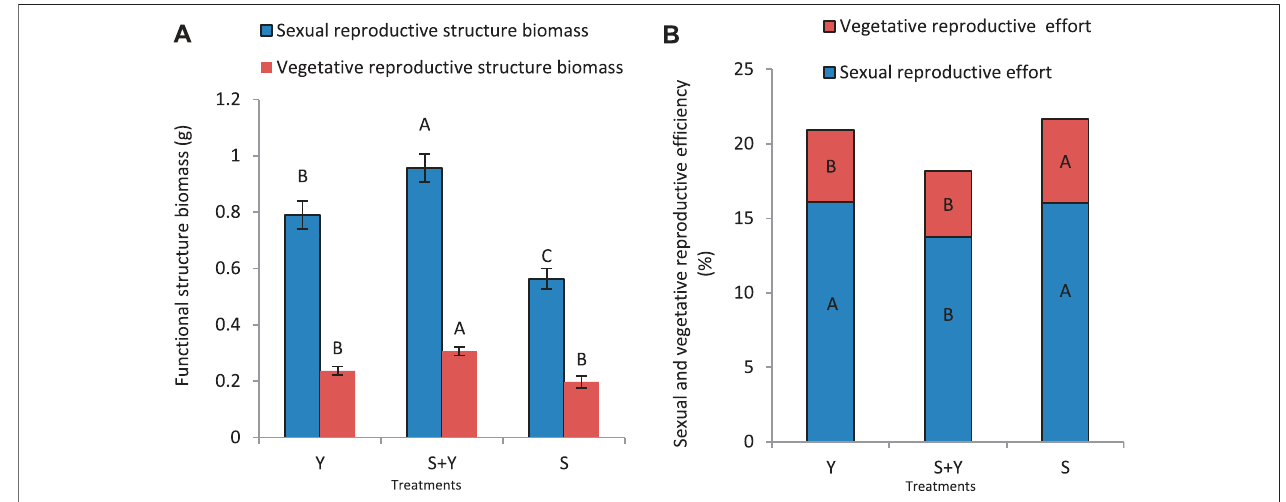
FIGURE 8 | Trade-off between grazing methods on sexual and vegetative reproduction of K. humilis in terms of (A) reproductive structure biomass and Nutrition structure biomass and (B) reproductive structure effectiveness and nutritional structure effectiveness. Capital letters indicate signi fi cant differences ( p < 0.05) among grazing methods.